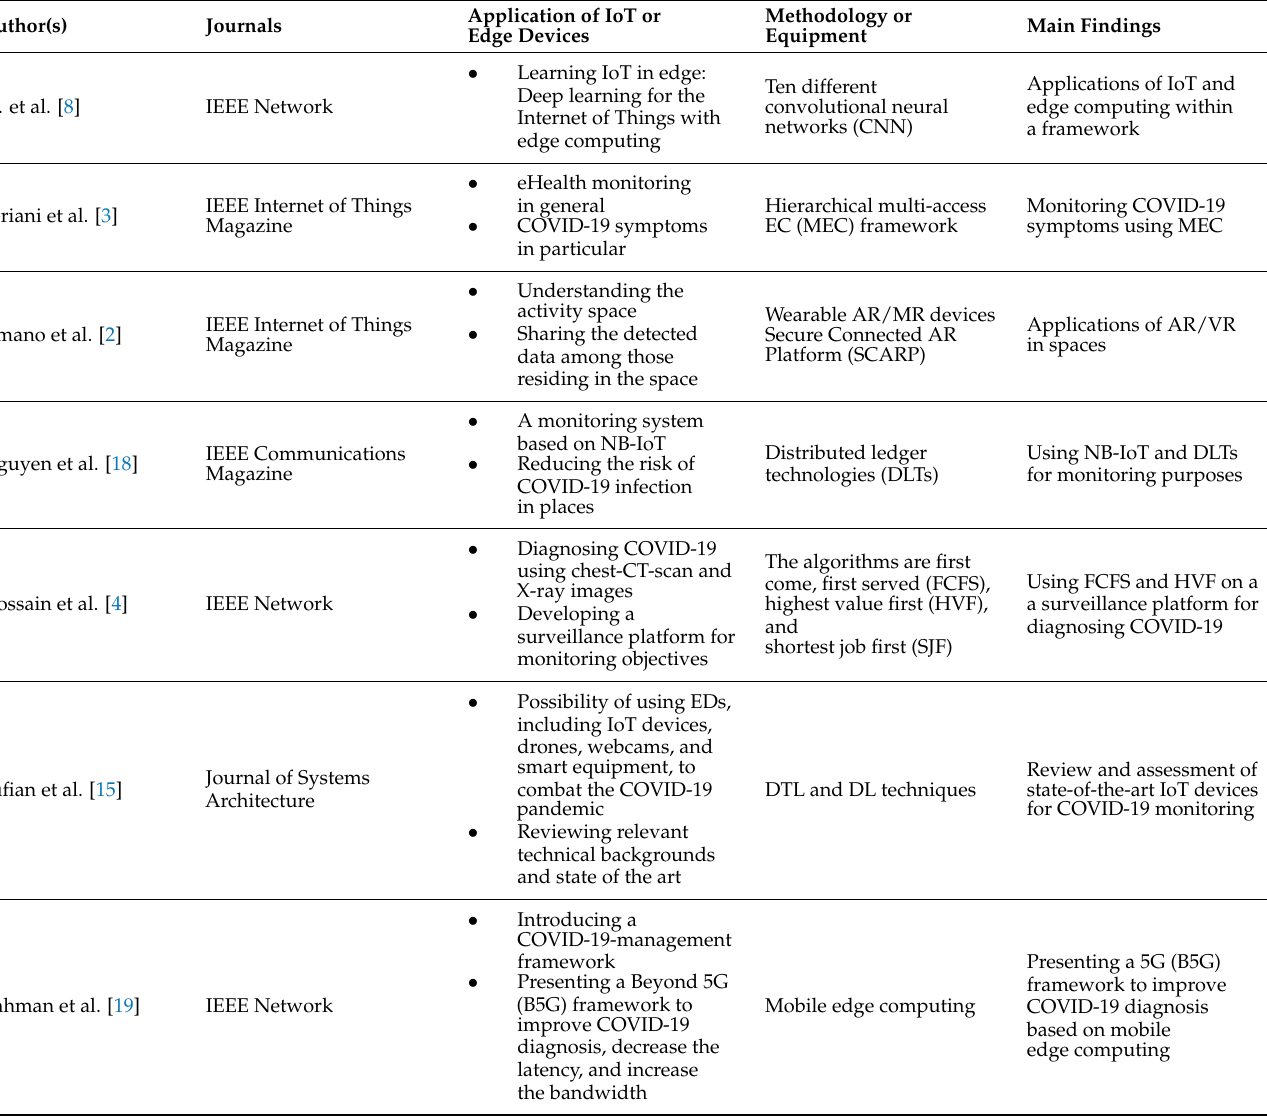
Table 1. Summary of the state of- the art of EC technology and IoT-based systems in